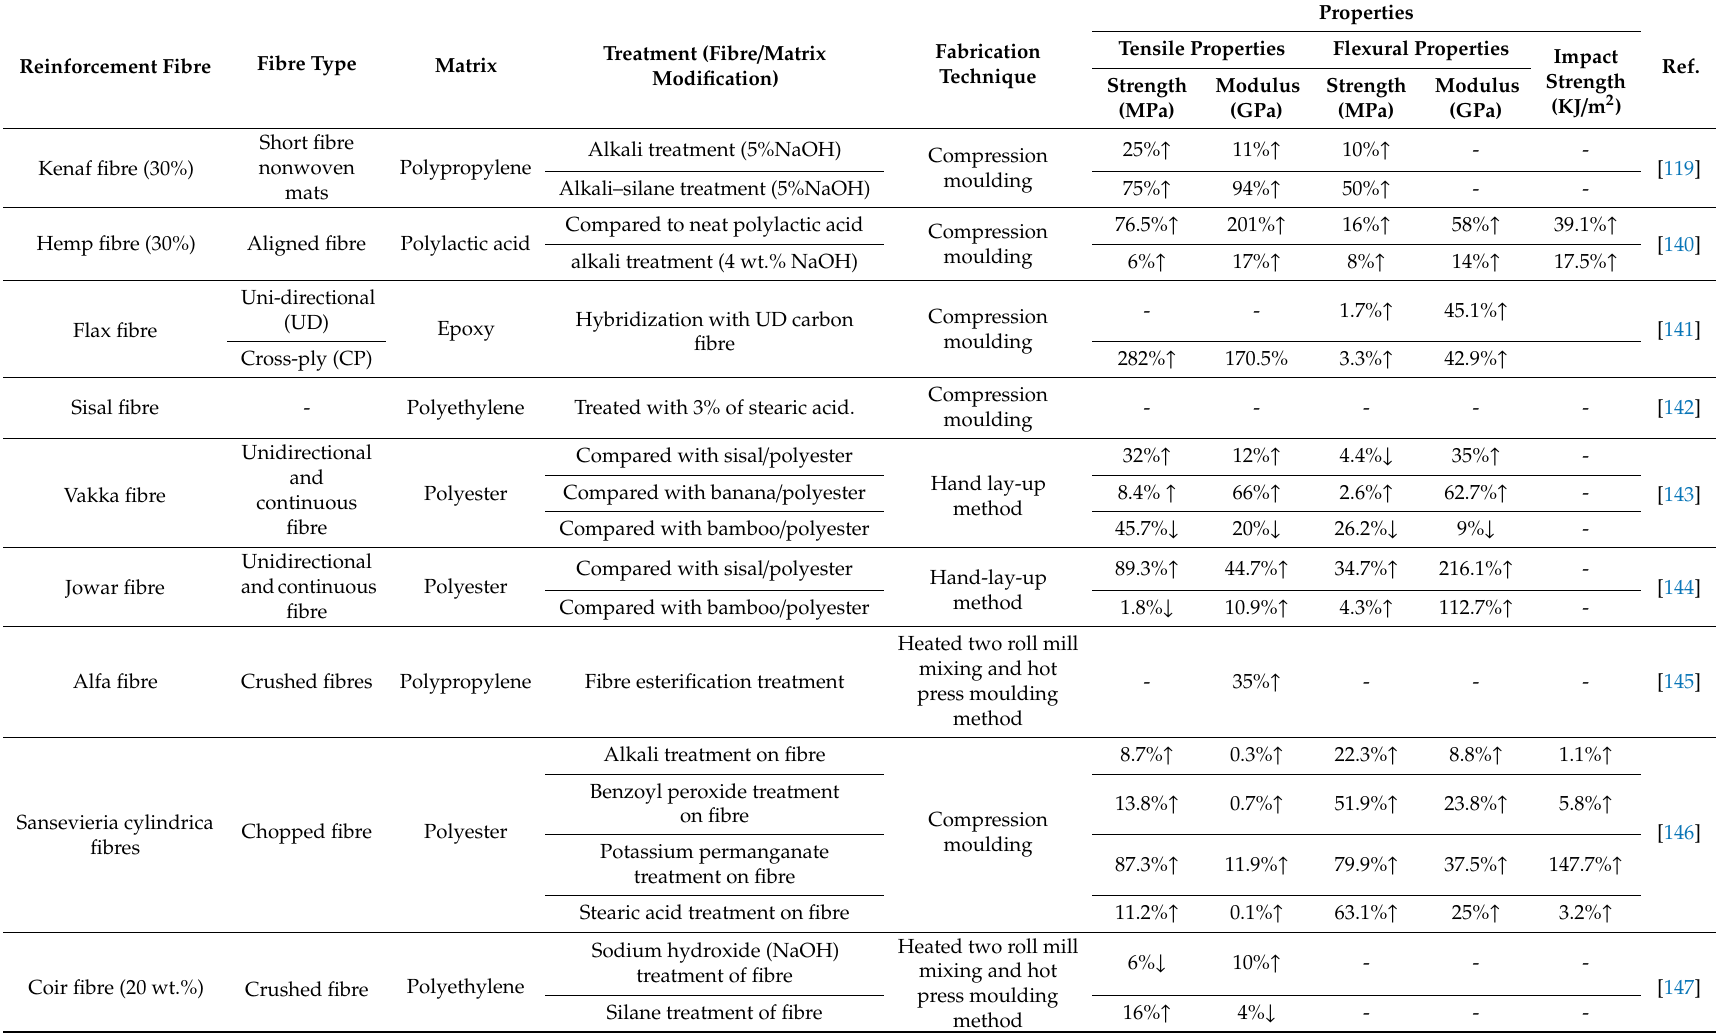
Table 4. Investigation of the mechanical properties of various natural fibre reinforced composites